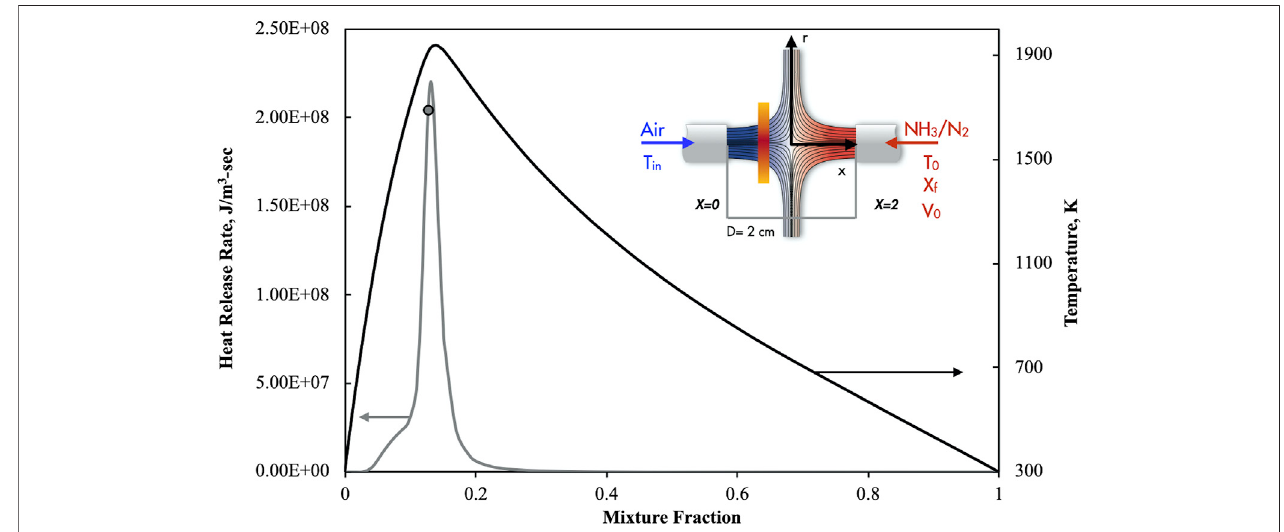
FIGURE 1 | Schematization of steady unidimensional diffusive layer con fi guration.